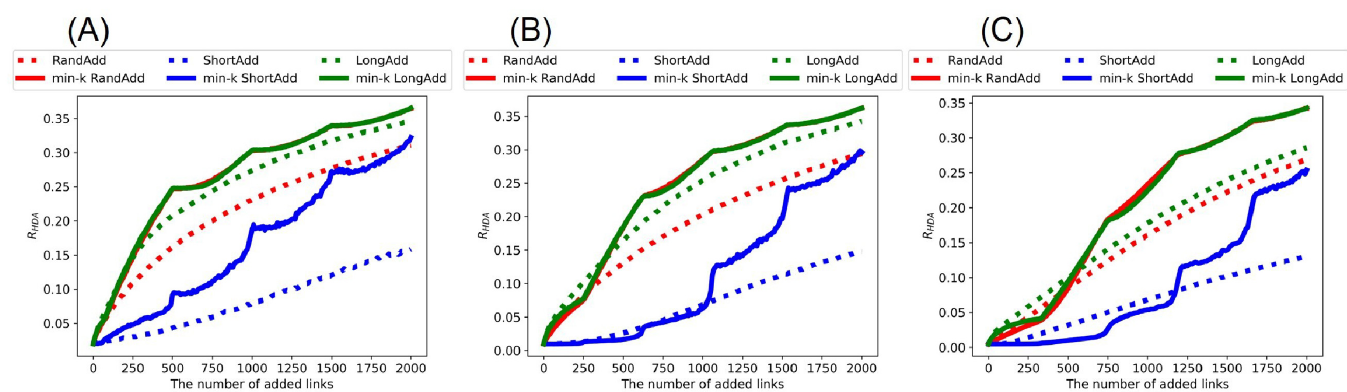
Fig 2. Robustness index against typical HDA attacks after adding links to random trees. The min- k RandAdd and min- k LongAdd methods (red and green solid lines) are the most effective for improving R HDA . For small numbers of added links less than (A) 170, (B) 380, and (C) 530, the LongAdd method (green dotted lines) is higher than other five methods. The initial random tree has (A) narrower, (B) exponential, and (C) power-law degree distributions. Red, blue, and green dotted lines correspond to RandAdd, ShortAdd, and LongAdd methods. Red, blue, and green solid lines correspond to min- k RandAdd, min- k ShortAdd, min- k LongAdd